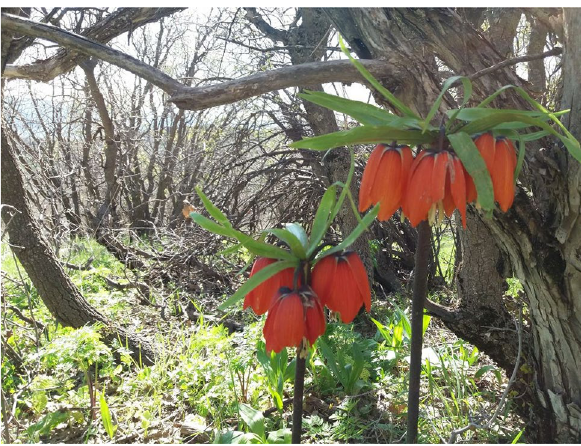
Figure 1. Fritillaria imperialis flower